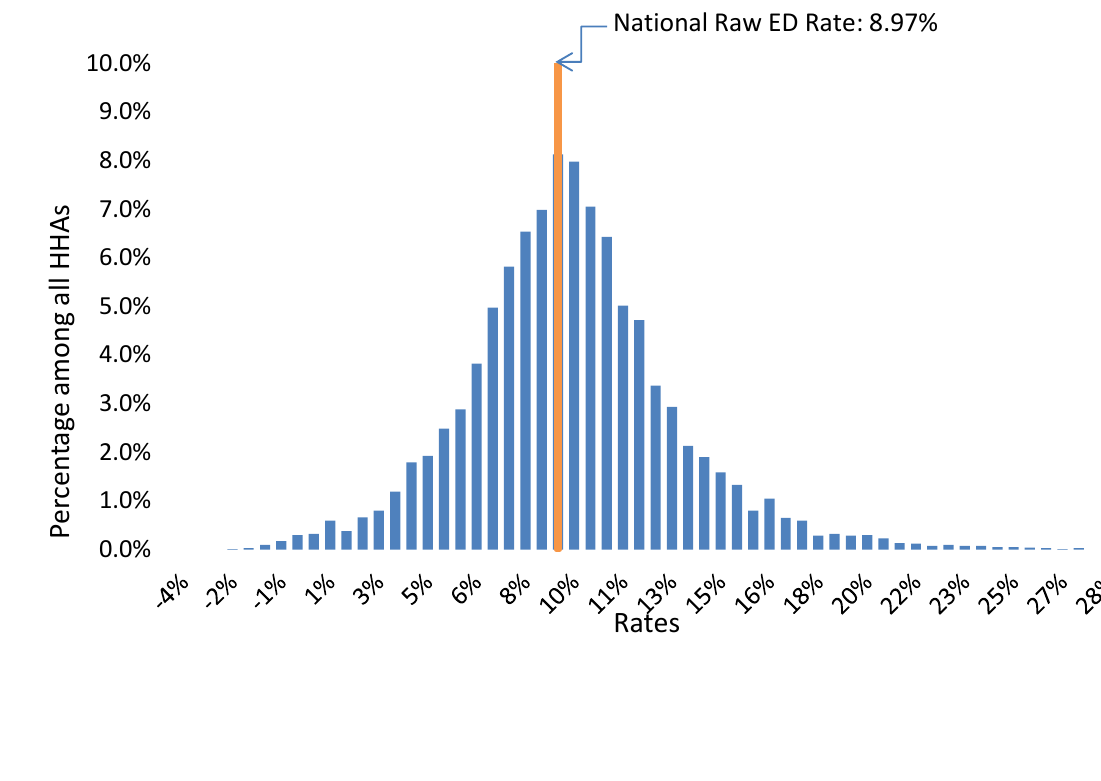
3.0% 2.0% 0.0%1.0% Rates Figure 13.2 shows the distribution of all HHAs’ performance on the 30-day risk-adjusted ED use without readmission measure. The FY 2012-2014 national raw ED use without readmission rate was 9.0%. Figure 13.2: HHA 30-Day ED Use without Re-Hospitalization Measure Performance, FYs 2012-2014 National Raw ED Rate: